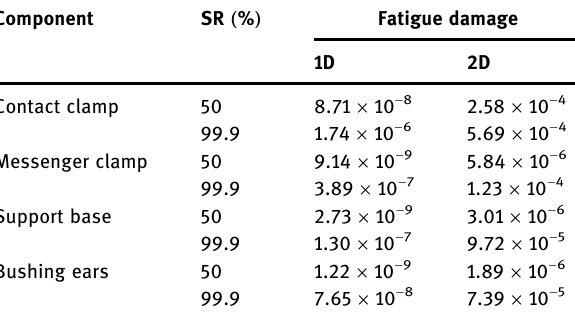
Table 10: Damage calculation in the 24 - h wind test Component SR ( % )